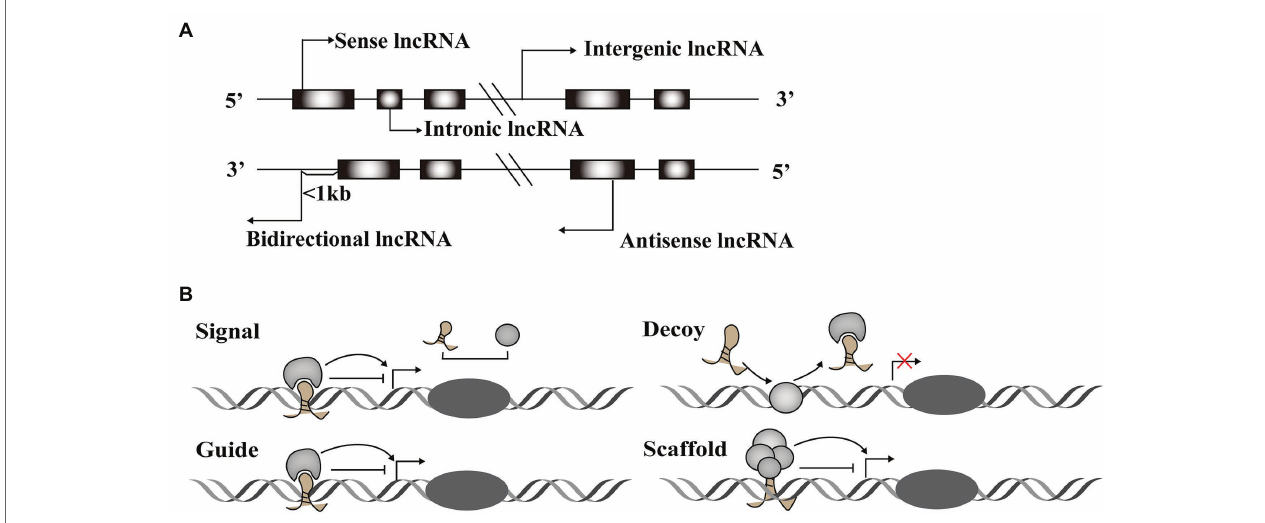
FIGURE 1 | Classification and function modes of Long noncoding RNAs (lncRNAs). (A) LncRNAs can be classified into five categories, including sense, antisense, intergenic, intronic, and bidirectional groups according to their relative location with the protein-coding genes. (B) LncRNAs function in four archetypes. Archetype I: As signals, lncRNAs can take part in signaling pathways to regulate gene expression. Archetype II: As decoys, lncRNAs combine with transcription factors to block the pathways. Archetype III: As guides, lncRNAs direct protein complexes to specific genome sites. Archetype IV: As scaffolds, lncRNAs recruit several proteins to form ribonucleoprotein